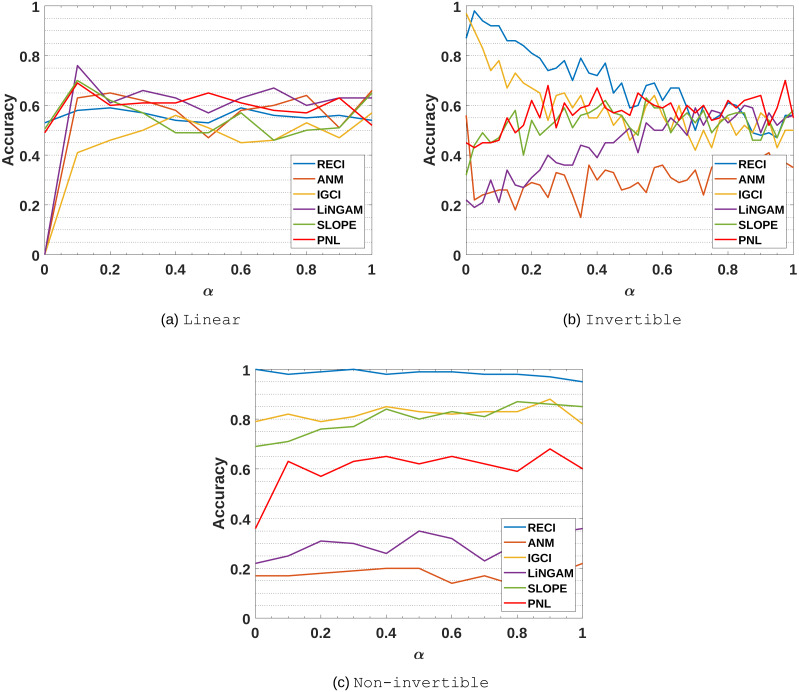
Evaluation results of all methods in the (A) Linear, (B) Invertible and (C) Non-Invertible data sets.The parameter α controls the amount of noise in the data.